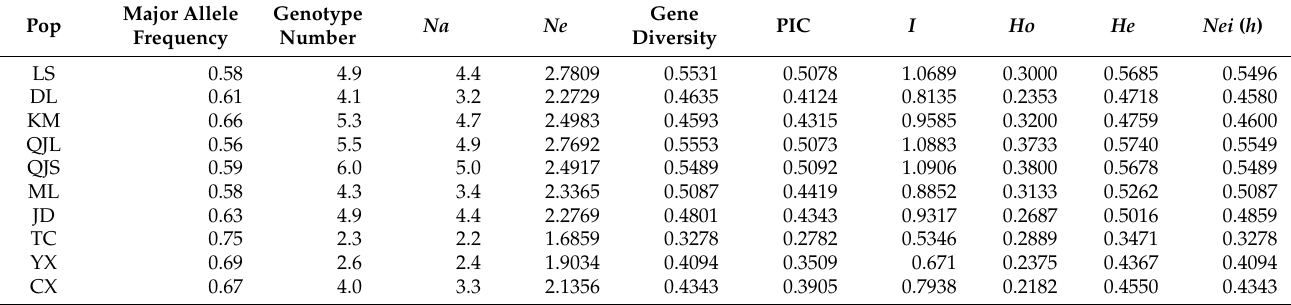
Table 4. The genetic diversity and genetic differentiation of cultivated